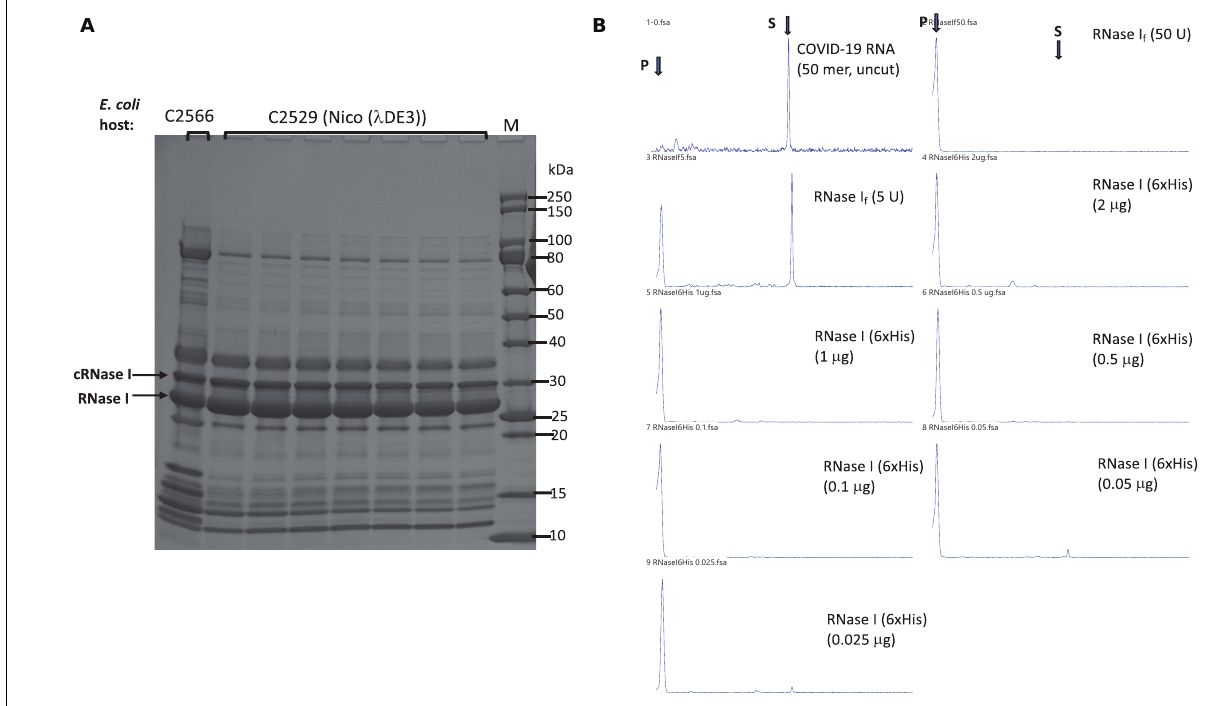
FIGURE 3 | Purification of RNase I (6 × His) and RNase activity assay. (A) Purification of RNase I (6 × His) from Nickel-NTA agarose column. Lane 1, RNase I (6 × His) pooled fractions from a nickel column (purified from T7 Express cell extract). Arrows indicate the cytoplasmic RNase I precursor (cRNase I) with the signal peptide (predicted MW 30.7 kDa), and the periplasmic RNase I with the signal peptide removed (predicted MW 27.0 kDa). (B) RNase activity on a FAM-labeled SARS-CoV-2 RNA (50 mer). S = substrate; P = cleavage product(s). Positive controls, 50 and 5 U of RNase I f (NEB). RNase I (6 × His) enzyme titration (2 µ g to 25 ng protein) was used in the activity assay to digest fixed amount of RNA (16 nM) in NEB buffer 3 at 37 ◦ C for 1 h. Proteinase K (1.6 U) was added to remove RNase I. The final cleavage products were analyzed by capillary electrophoresis (CE), and peaks were visualized by PeakScan.